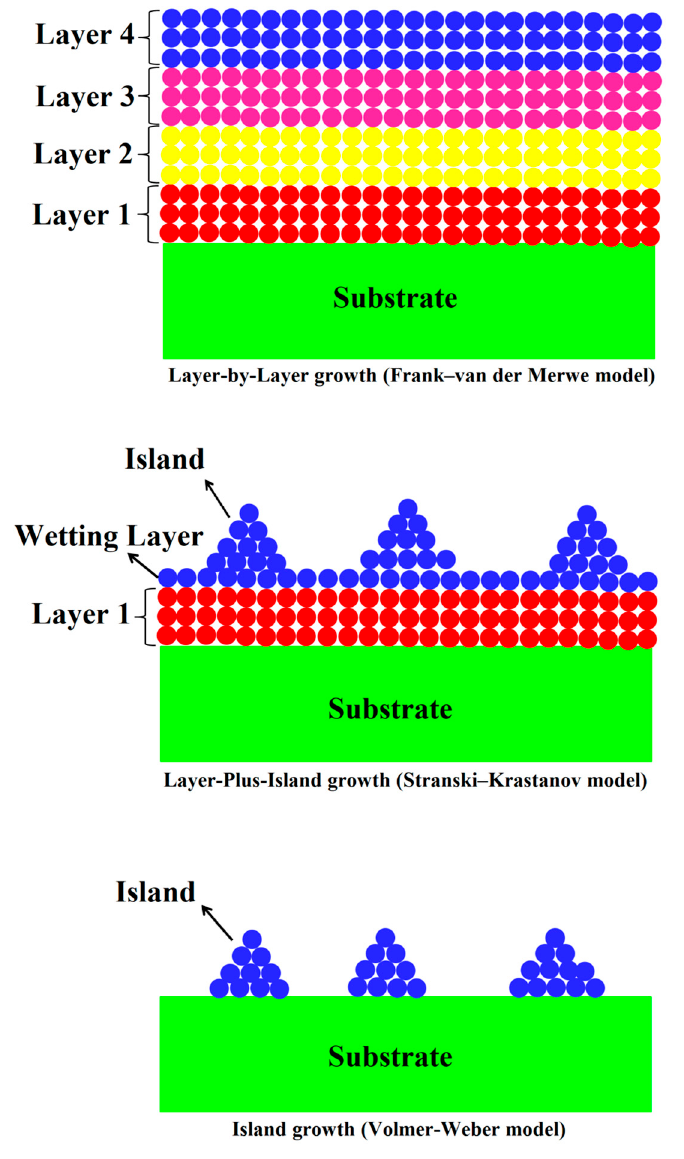
Figure 3. Basic models available for the growth process and layering on the substrate.